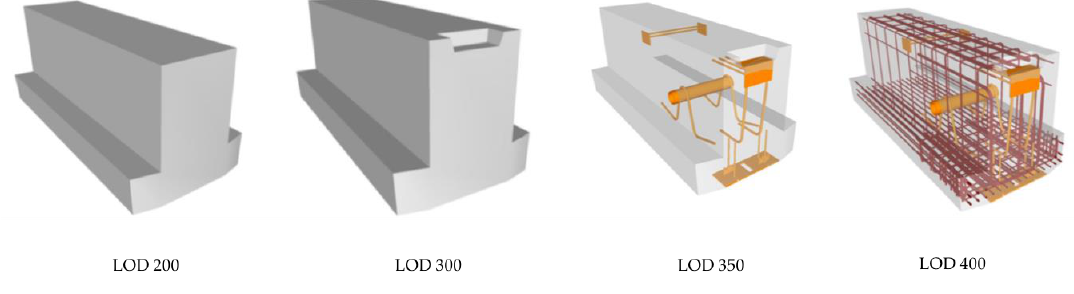
Figure 2. A precast structural inverted T beam (concrete) model from LOD 200 to LOD 400